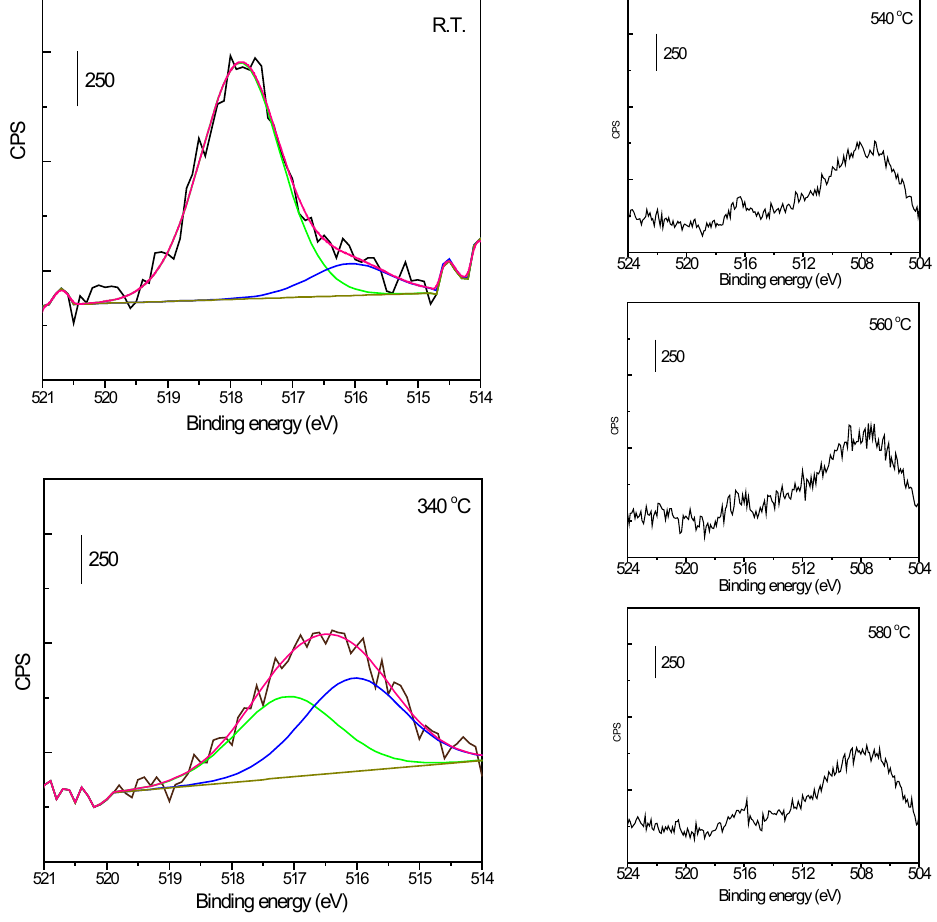
Figure 9. V2p 3/2 peaks obtained in isobutane atmosphere for the APMV/CPM sample (black: original spectrum, pink: accumulative curve, green: V 5+ and blue: V 4+